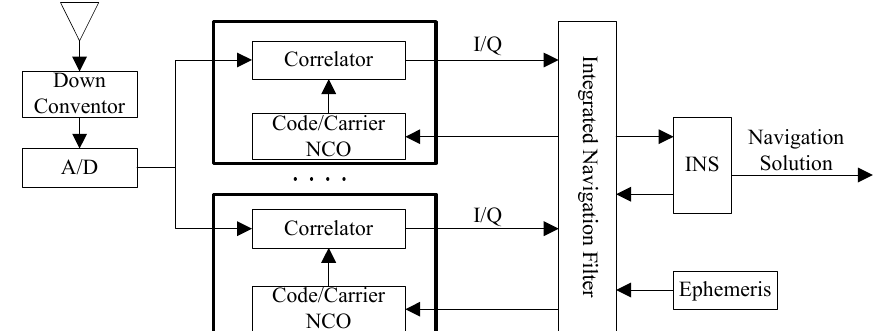
Figure 1. Central design of ultra-tight GPS/INS